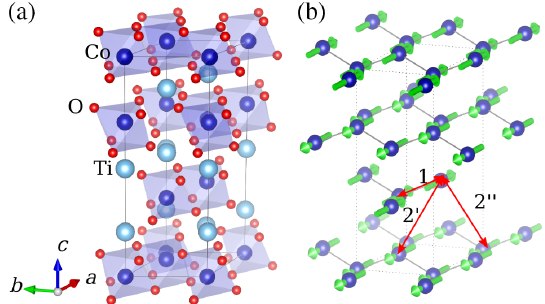
FIG. 1. (a) Structure of CoTiO 3 . A nonprimitive hexagonal unit cell, which is used to describe our data, is indicated by solid black lines. (b) Magnetic structure of the Co 2 þ sublattice. The Co 2 þ magnetic moments (shown by green arrows) order ferromagneti- cally within each honeycomb plane and antiferromagnetically along the c axis. Red arrows labeled 1, 2 0 , and 2 00 are the magnetic couplings considered in the spin-wave calculation.